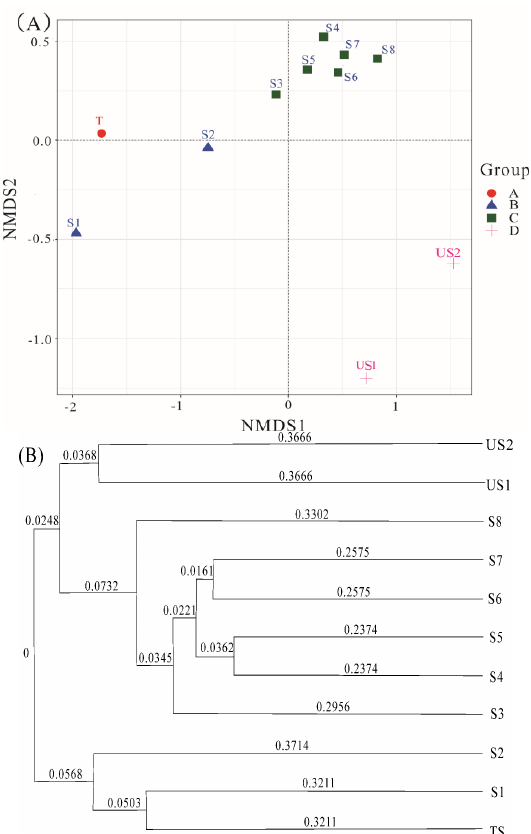
Figure 6. Cluster analysis of soil samples ( A ): the unweighted unifrac analysis (NMDS) plot based on the unweighted UniFrac distances; ( B ) the unweighted pair group with arithmetic mean (UPGMA) plot based on Unweighted pair-group method with arithmetic means.